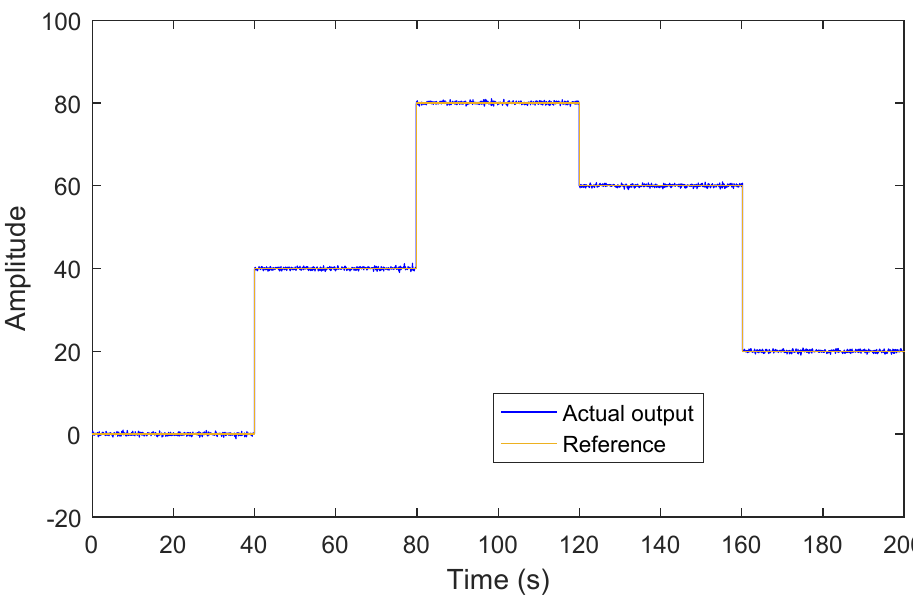
Figure 7. Response of SLSSO-based controller for variable step input with disturbance for loop